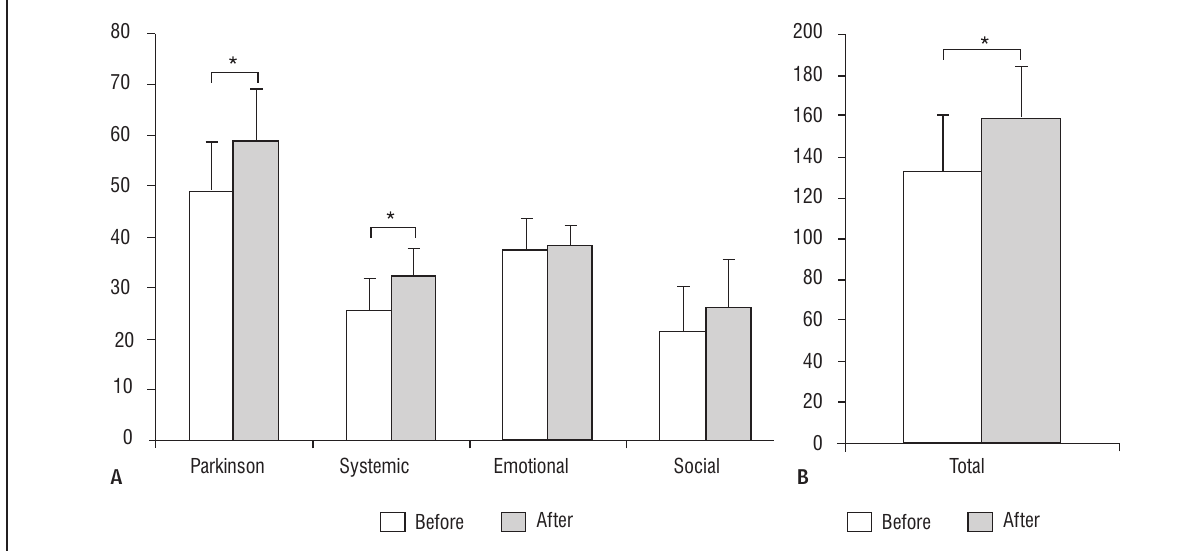
Figure 4 - Parkinson Disease Quality of Life Questionnaire (PDQL-BR): A – Subcategories: Parkinson, Systemic, Emotional and Social, before and after treatment respectively; B – Total